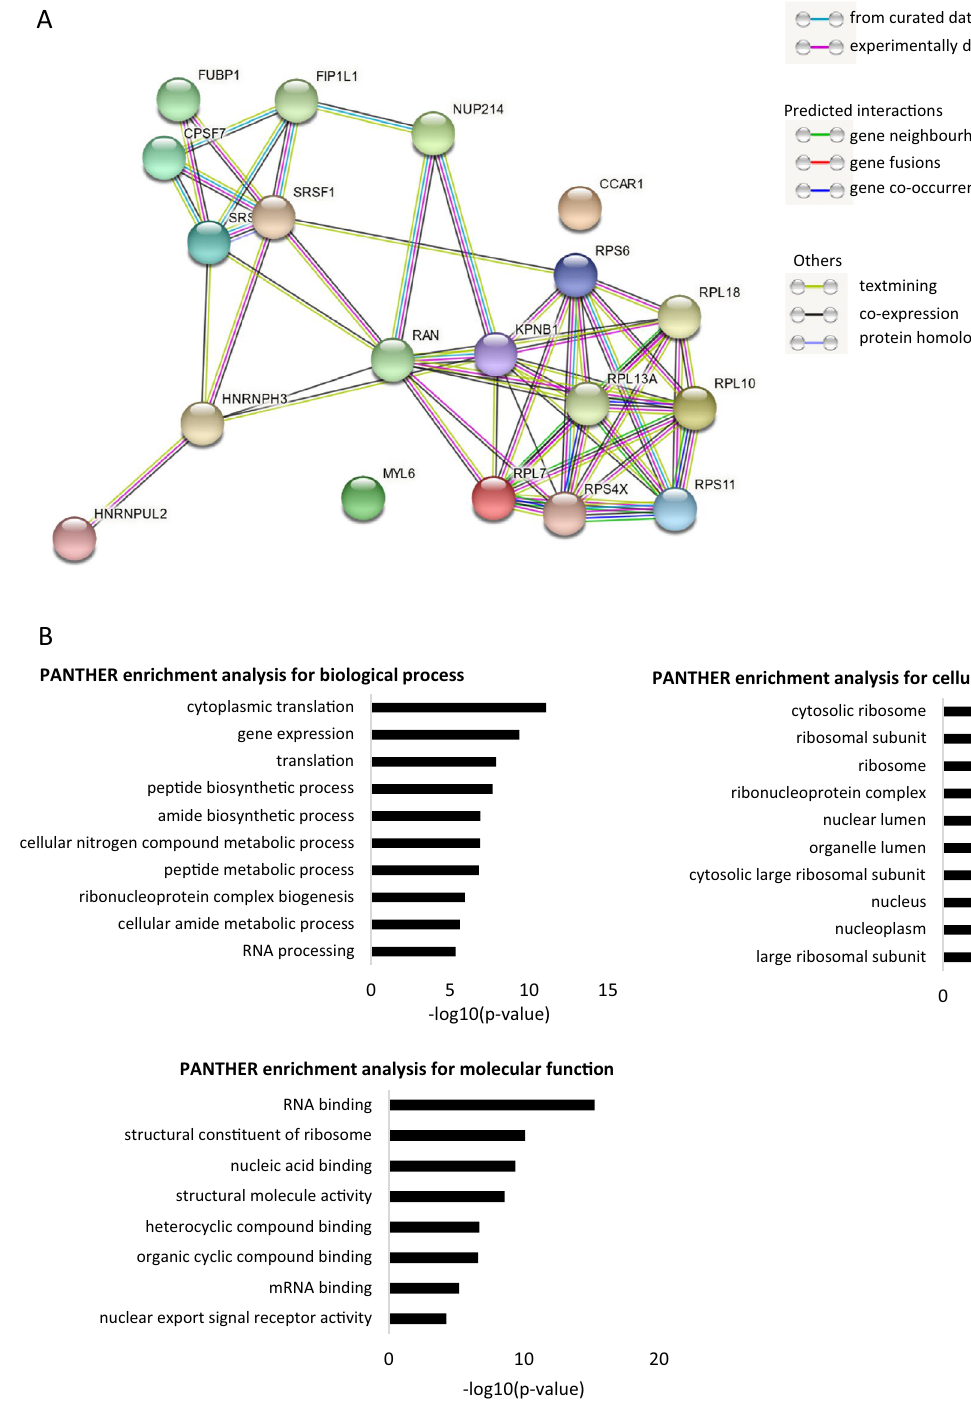
Figure 4. Protein–protein interaction network and gene ontology analyses of Kpnβ1 binding proteins unique to cancer cells. ( A ) STRING protein–protein interaction (PPI) network analysis of 18 unique Kpnβ1-interacting proteins reveals a high degree of protein–protein interaction. A medium confidence level (0.4) was used. The circles represent proteins, while the straight lines represent the interactions between different proteins. ( B ) PANTHER gene ontology analysis of 18 Kpnβ1-interacting proteins common to cancer and non-cancer cells. The 10 most significantly enriched biological processes, cellular components and molecular functions are